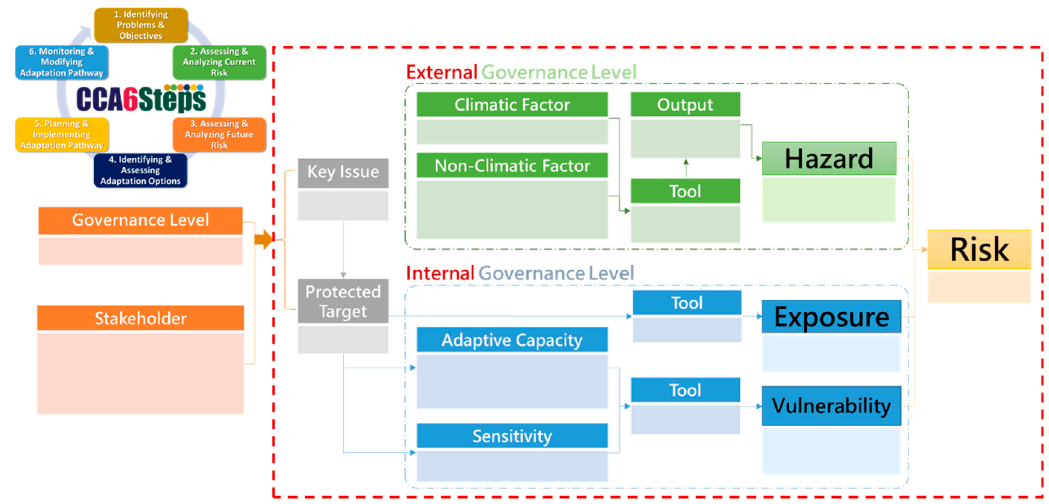
Figure 6. The definition of climate risk template developed by [23], and the items in the red dotted box are the main part on which we focus to discuss hazard, exposure, and vulnerability.